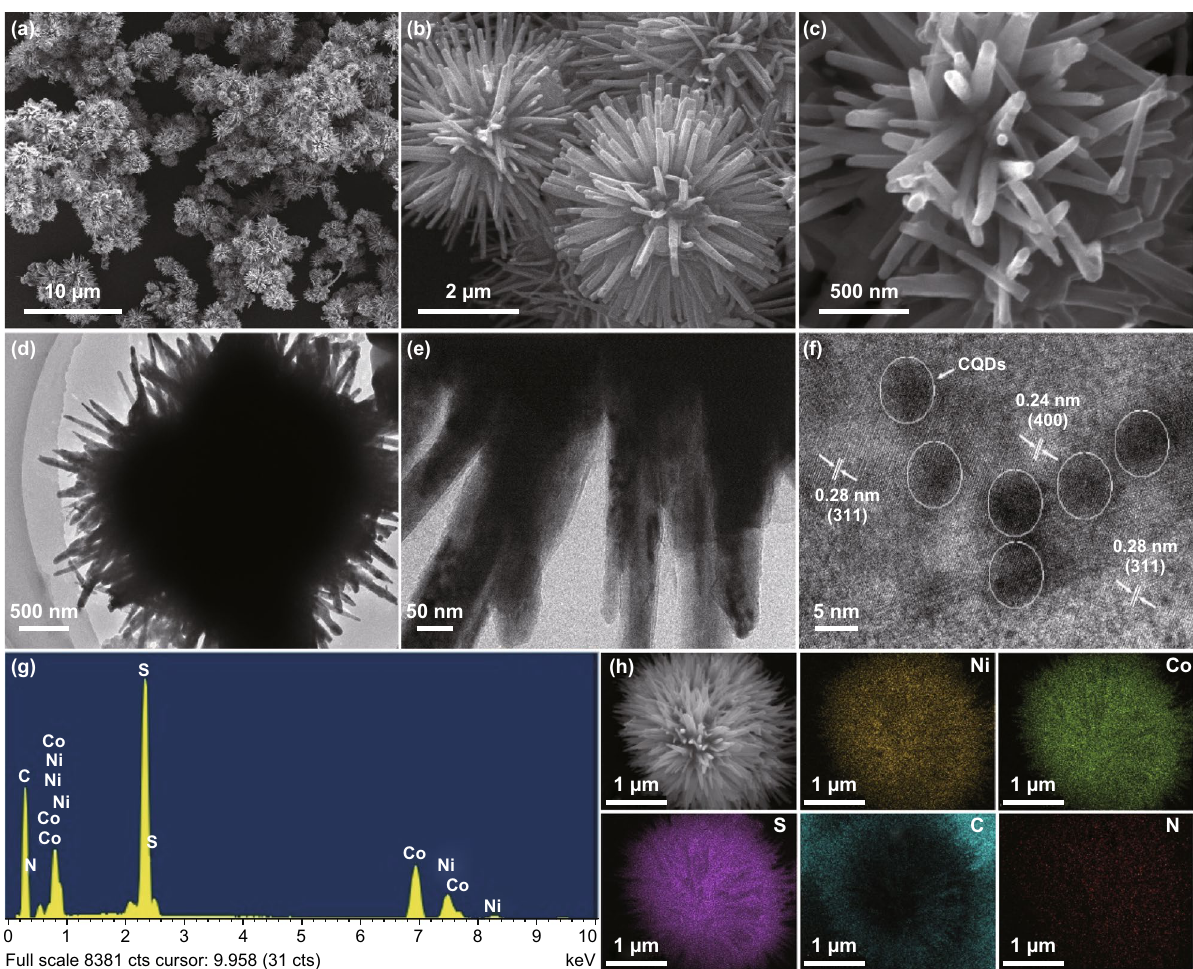
Fig. 3 a – c FESEM images, d, e TEM images, f HRTEM image, g EDS spectrum and h corresponding elemental mappings of Ni, Co, S, C and N elements of the